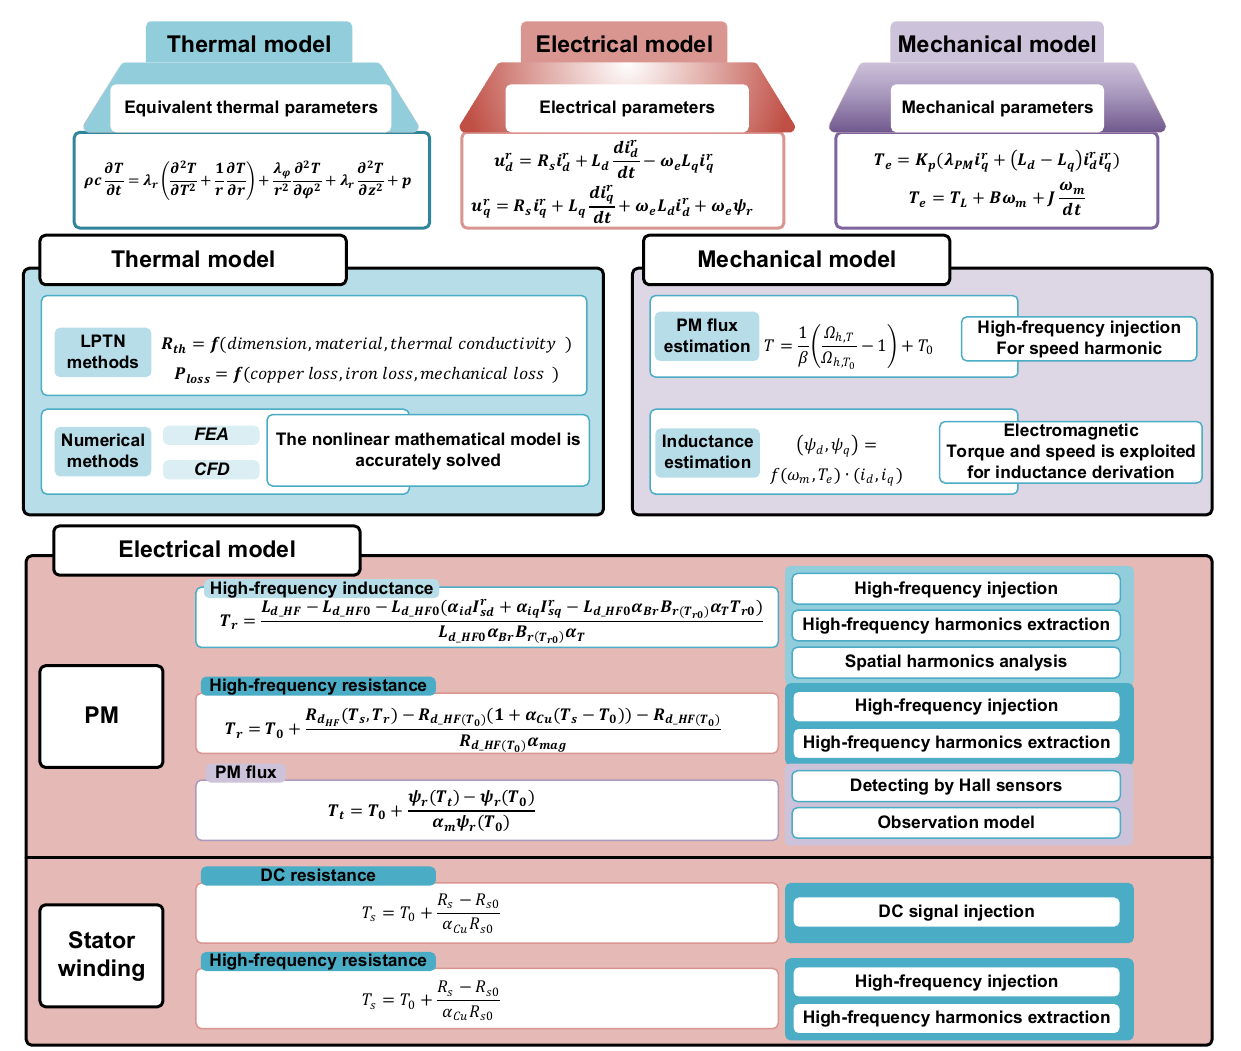
Figure 3. Demonstration of specific techniques for model-based